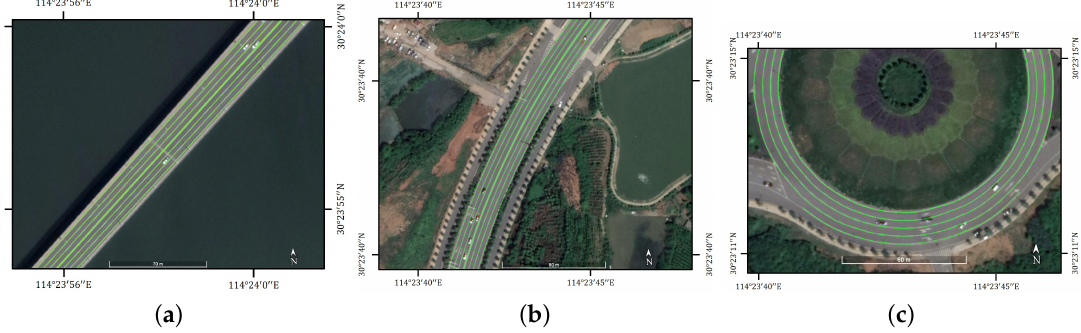
Figure 23. The mapping results are overlaid with Google Earth images in ( a ) a straight road section, ( b ) a curved road section, and ( c ) the roundabout.